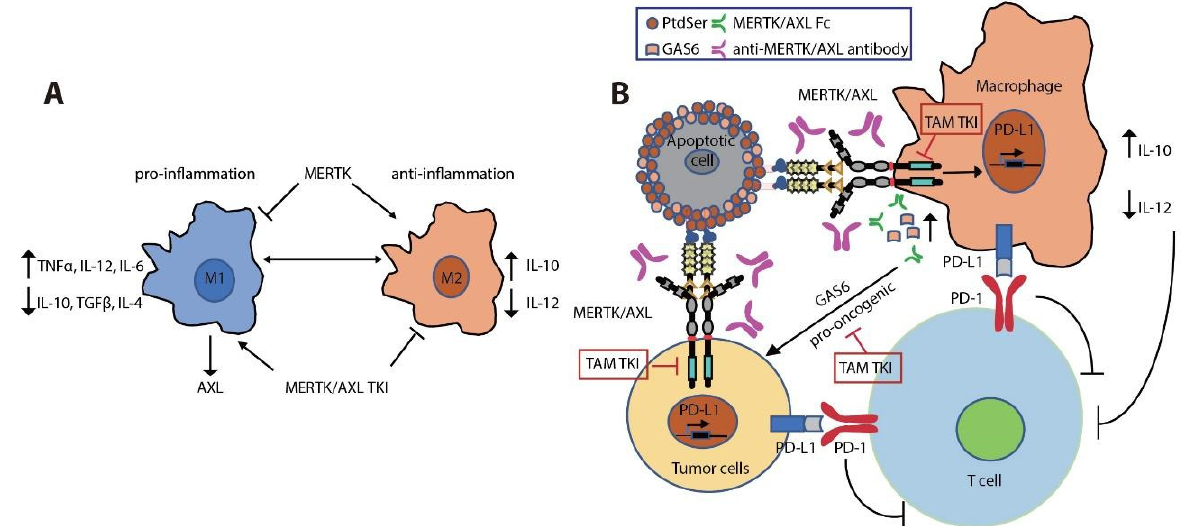
Figure 3. Immune regulatory roles of MERTK and AXL in the TME. ( A ) MERTK signaling favors macrophage to M2 type to generate immunosuppressive microenvironment through releasing anti-inflammatory cytokine IL-10 and decreasing the release of pro-inflammatory cytokines IL-12 and TNF α . While expression of AXL is promoted by pro-inflammatory M1 macrophage, treatment with MERTK/AXL TKI promotes M2 to M1 macrophage development. ( B ) MERTK/AXL signaling favors tumor growth in cancer through two independent mechanisms. Enhanced GAS6 secretion by tumor-associated macrophages promote tumor growth through the activation of oncogenic MERTK/AXL signaling in tumor cells. Activation of MERTK in tumor-associated macrophages and in tumor cells promotes PD-L1 expression, resulting in suppression of T cell activation. Besides, the immunosuppressive cytokine environment limits T cell proliferation and effector functions.